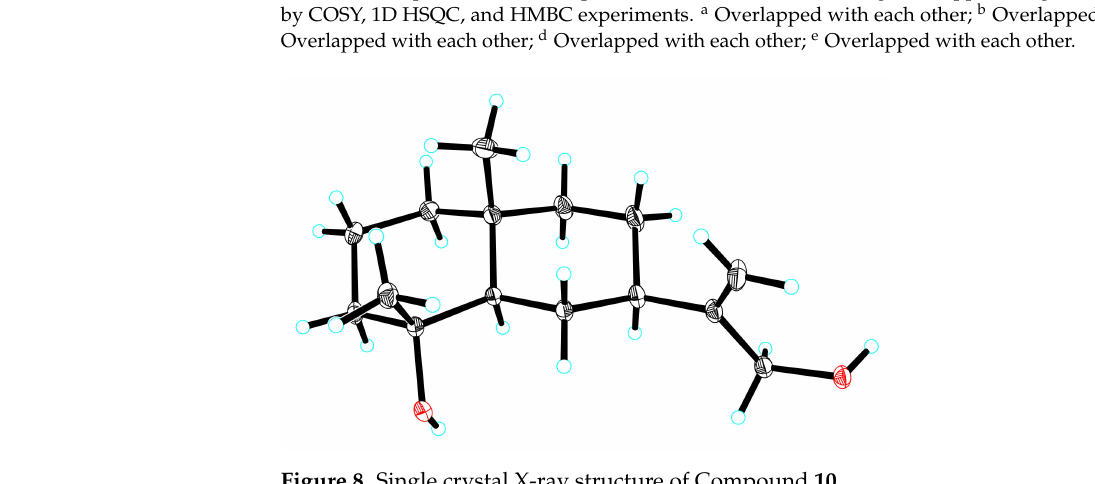
molecular formula of C 17 H 30 O 2 ( ∆ mmu 0.20), as deduced from the HRESIMS (Calcd. for C 17 H 30 O 2 Na, m / z 289.3594), 13 C NMR and HSQC data. The 1 H and 13 C NMR (MeOH- d 4